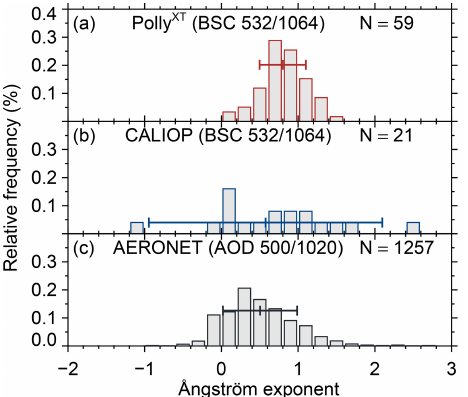
Figure 15. Frequency distribution of the vertical integrated particle- backscatter-related Ångström exponent (532 and 1064nm) of (a) Polly XT and (b) CALIOP with an increment of 0.2. Addition- ally, the frequency distribution of the AOT-related Ångström expo- nent determined by Sun photometer measurements in Rio Gallegos is illustrated. N gives the number of measurements. The horizontal error bar indicates the standard